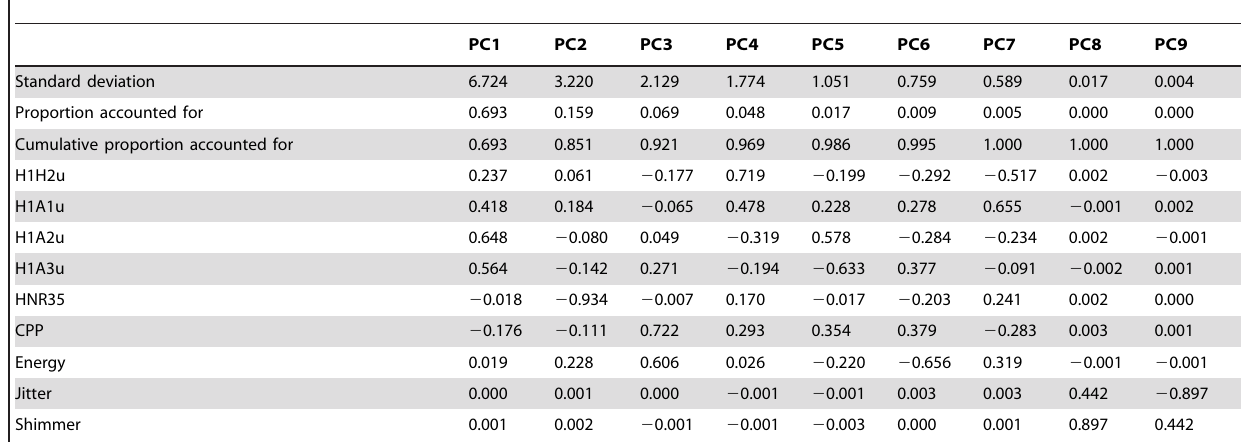
Table 4. The cumulative proportion of variance accounted for and loadings from the PCA of voice quality measures for male